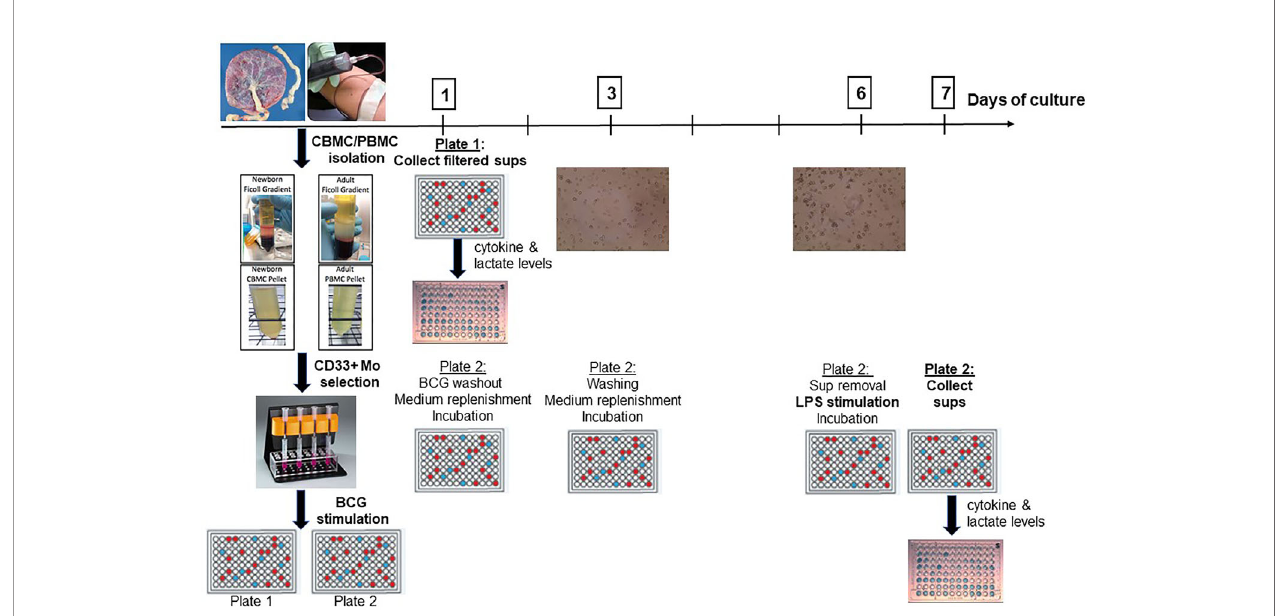
FIGURE 1 | A human in vitro platform to assess age-dependent BCG training. Peripheral venous blood was drawn from healthy adult volunteers and cord blood was collected from healthy term ( ≥ 37 weeks gestation) elective cesarean deliveries. After PBMC and CBMC isolation, pure CD33+ Mos were isolated by immunomagnetic separation and plated in two separate 96-well plates. After 1h of resting, Mos were stimulated with control RPMI medium or with BCG. Supernatants were harvested from the fi rst plate at 24h post-stimulation for Day 1 cytokine and lactate measurements. The second plate was further cultured after BCG was fi ltered out at 24h to allow time for immune training. After intermediate washing and culture medium replenishment steps, trained and untrained (control) monocytes were stimulated at Day 6 with LPS for 24h at which point supernatants were harvested for cytokine and lactate measurements. PBMC, peripheral blood mononuclear cells; CBMC, cord blood mononuclear cells; Mo, monocyte; sups,